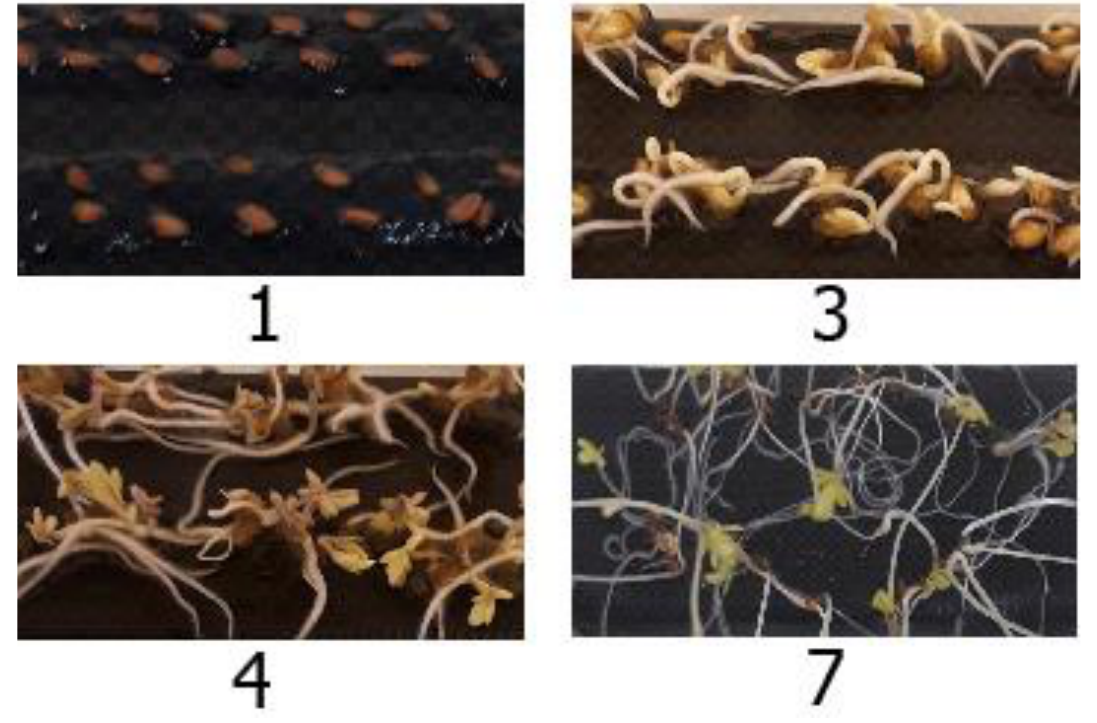
Figure 8. Typical photographs of seed germination stages (1st, 3rd, 4th, and 7th days) (for gel prepared in the presence of DNDs).